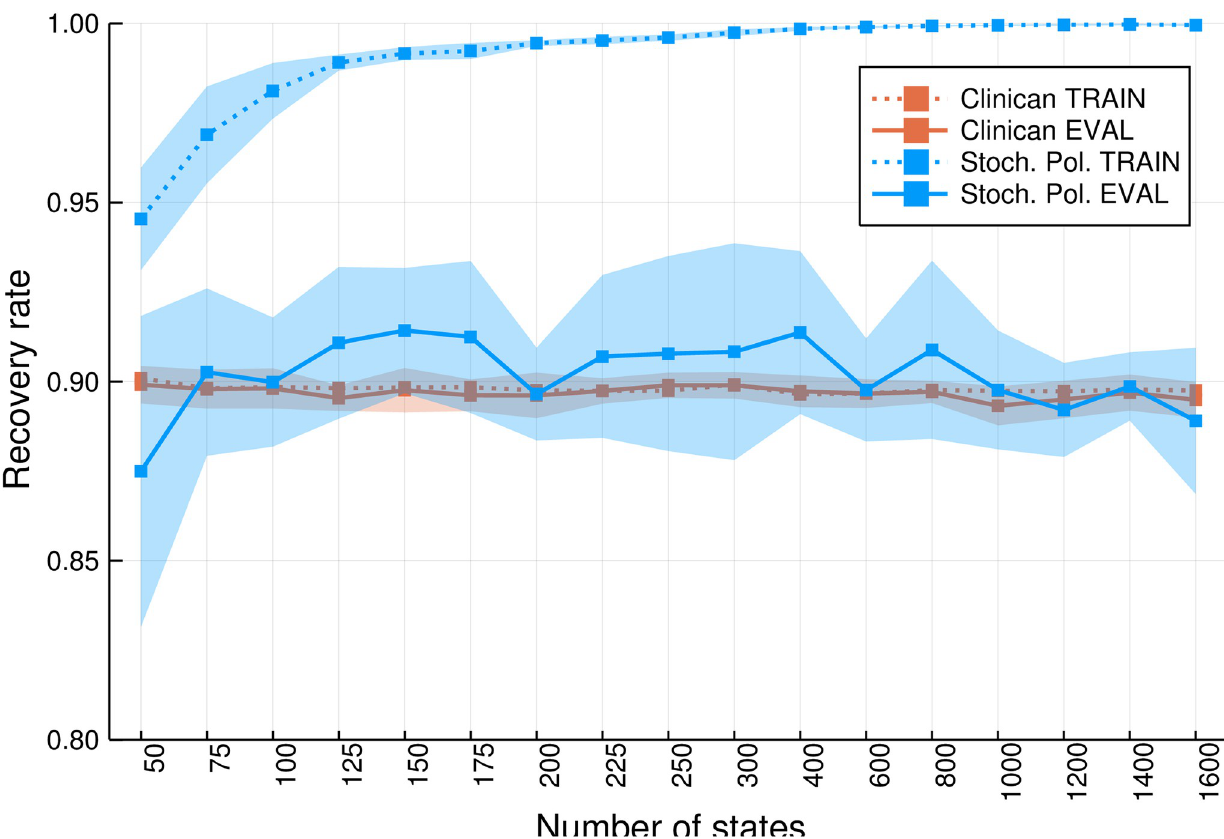
Fig 3. Comparison of the performance of stochastic policies on the training and test simulators for different numbers of states.